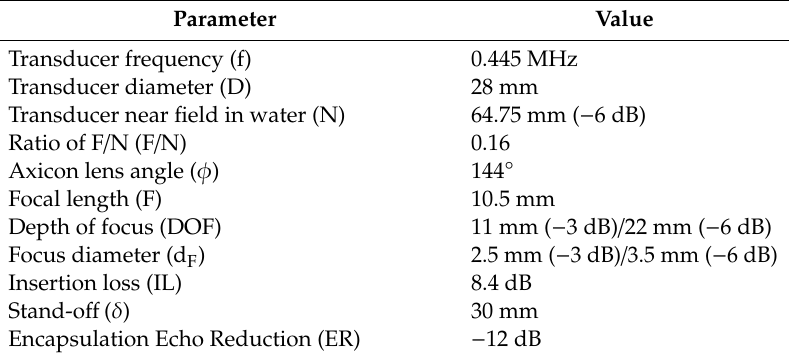
Figure 2. Photograph of the ultrasound test tank showing the axicon lens equipped transducer detail, parietal bone phantom, and hydrophone. Table 2. Specifications of the axicon lens characterized. Table 2. Specifications of the axicon lens characterized.